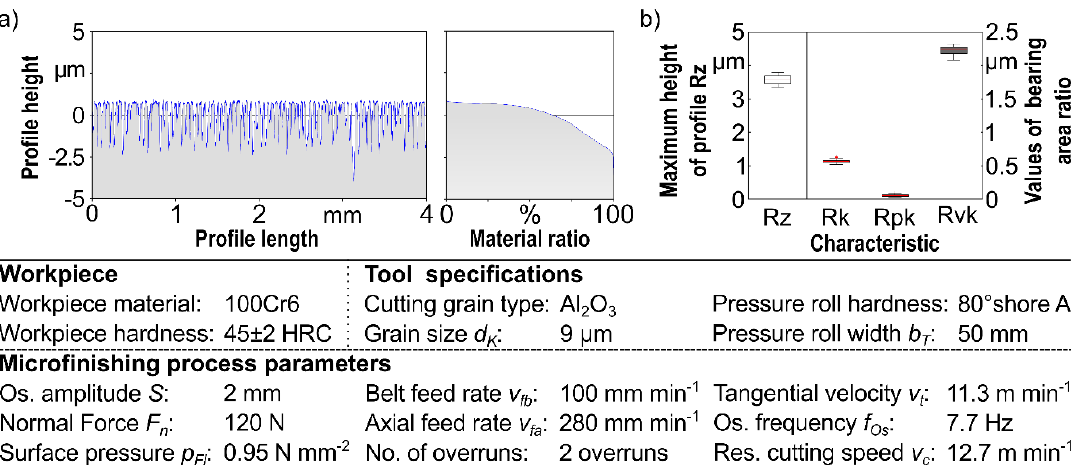
Figure 8. Resulting surface for the second rough microfinishing step by means of ( a ) the profile and material ratio curve and ( b ) surface